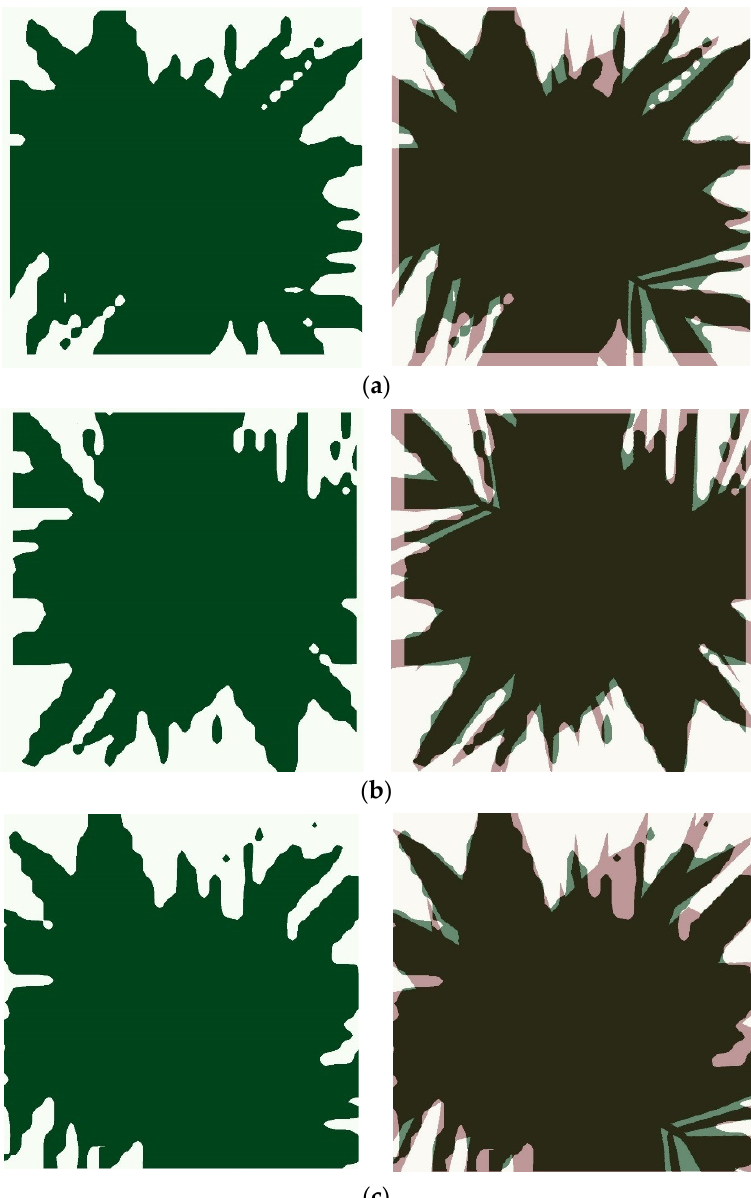
Figure 13. Example of the segmented images at different results of IoU. Figures on the left are the mask predicted using the Mask RCNN, while figures on the right are the predicted mask (green) overlayed on the actual mask (red). ( a ) IoU = 0.8598, ( b ) IoU = 0.8829 and ( c ) IoU = 0.8944.